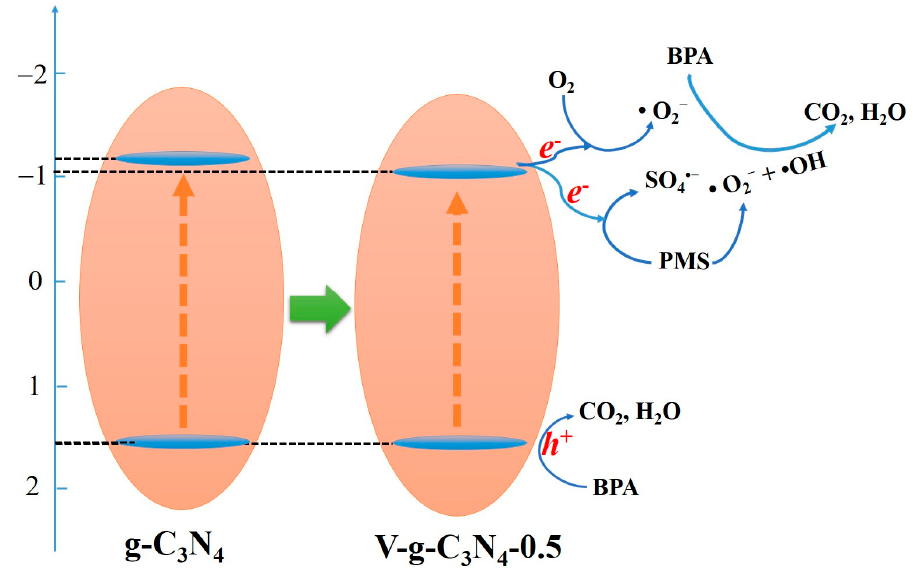
Figure 11. The proposed catalytic mechanism of PMS activation on the V-doped g-C 3 N 4 .